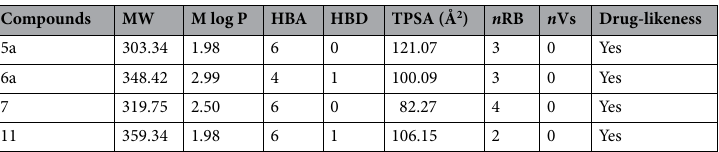
Table 3. Important computed parameters of Lipinski’s rule of five, its violation and drug-likeness of the most potent compounds 5a , 6a , 7 , and 11 . MW molecular weight ≤ 500, LogP logarithm of partition coefficient between n-octanol and water ≤ 5, HBA hydrogen-bonded acceptor ≤ 10, HBD hydrogen-bonded donor ≤ 5, TPSA topological polar surface area ≤ 140, nRB number of rotatable bonds ≤ 10, nVs number of violation from lipinski’s rule of five ≤